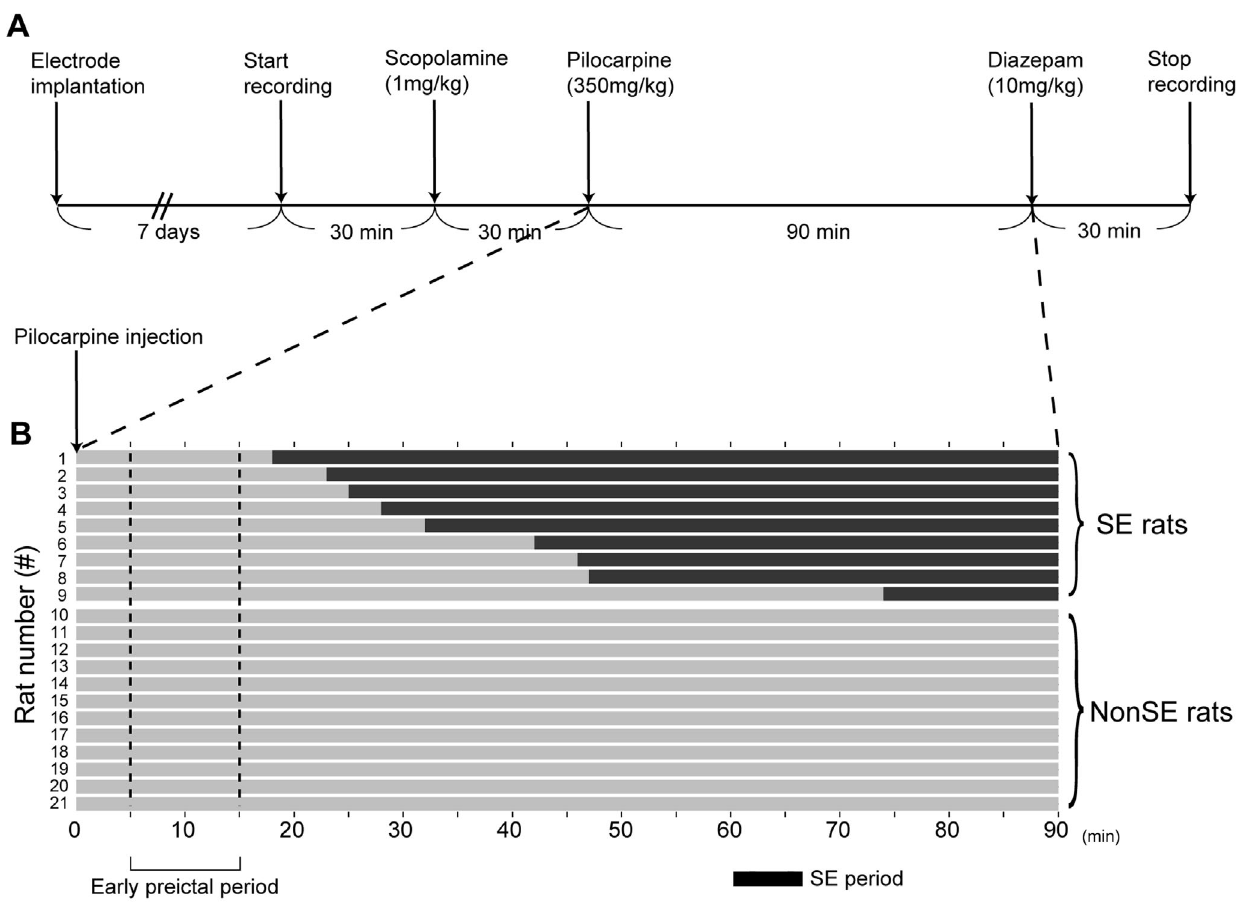
Figure 1. Outline of the experimental procedure. A . Experimental steps for induction of status epilepticus (SE). B . Temporal profiles of SE in 9 rats after injection of pilocarpine. No SE was identified in 12 rats. The black bar indicates the occurrence of SE. The early post-pilocarpine period was defined as the time period of 5–15 min after injection of pilocarpine, as delimited between the two vertical dashed lines.